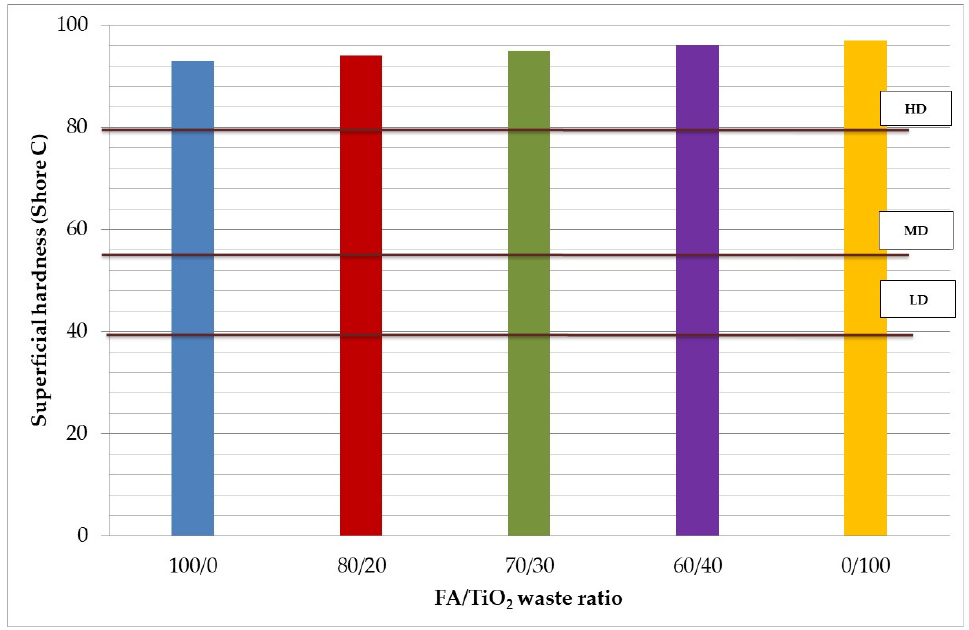
Figure 4. Superficial hardness results. Comparison with EN